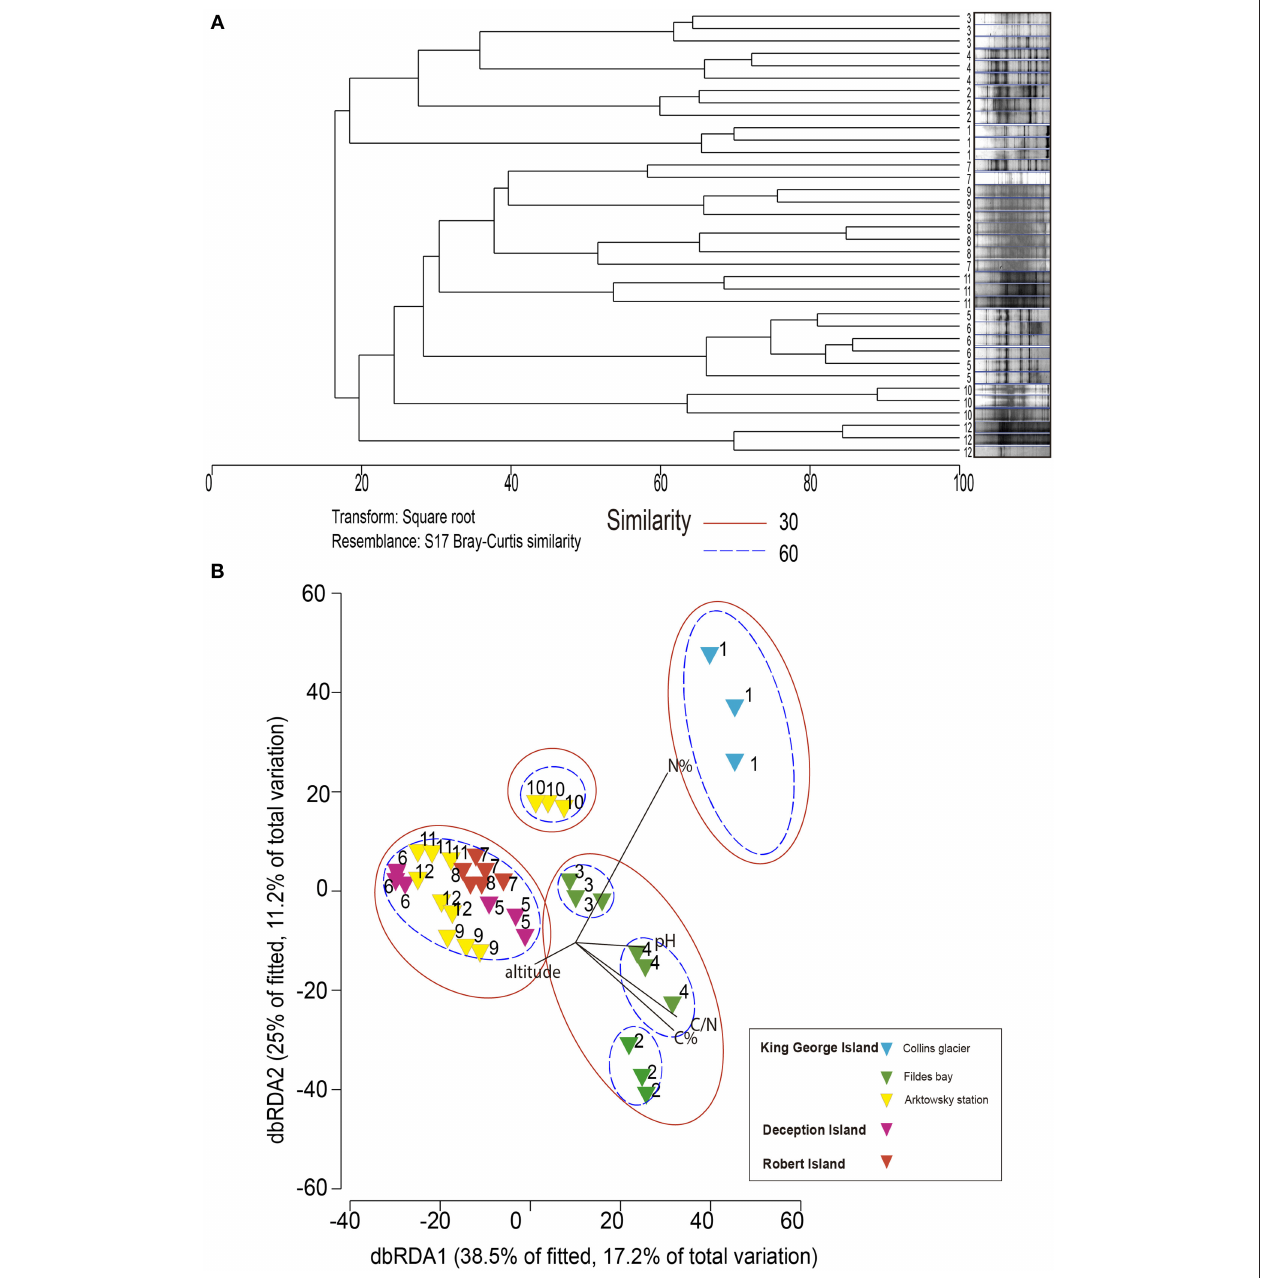
FIGURE 4 | Dendrogram (A) and nonmetric multidimensional scaling (B) analysis of DGGE profiles (18S rRNA gene) from soil communities of the Antarctic pristine